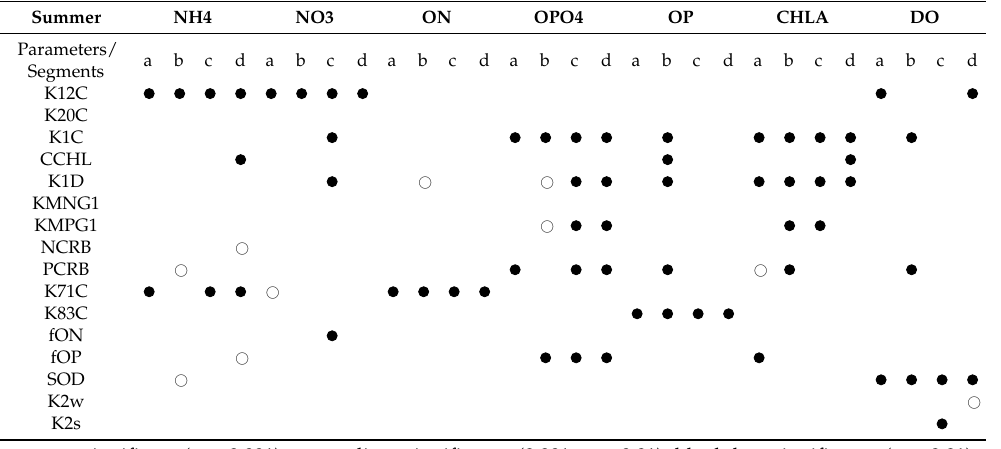
Figure 5. Parameter correlation: grey and red edges are positive and negative correlations, respectively. ( a ) uSSR at Medicine Hat, ( b ) uSSR at Leader, ( c ) lSSR at Outlook, and ( d ) lSSR at Clarkboro Ferry.